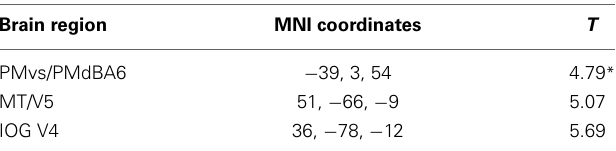
Table 7 | VO-AV. Brain region MNI